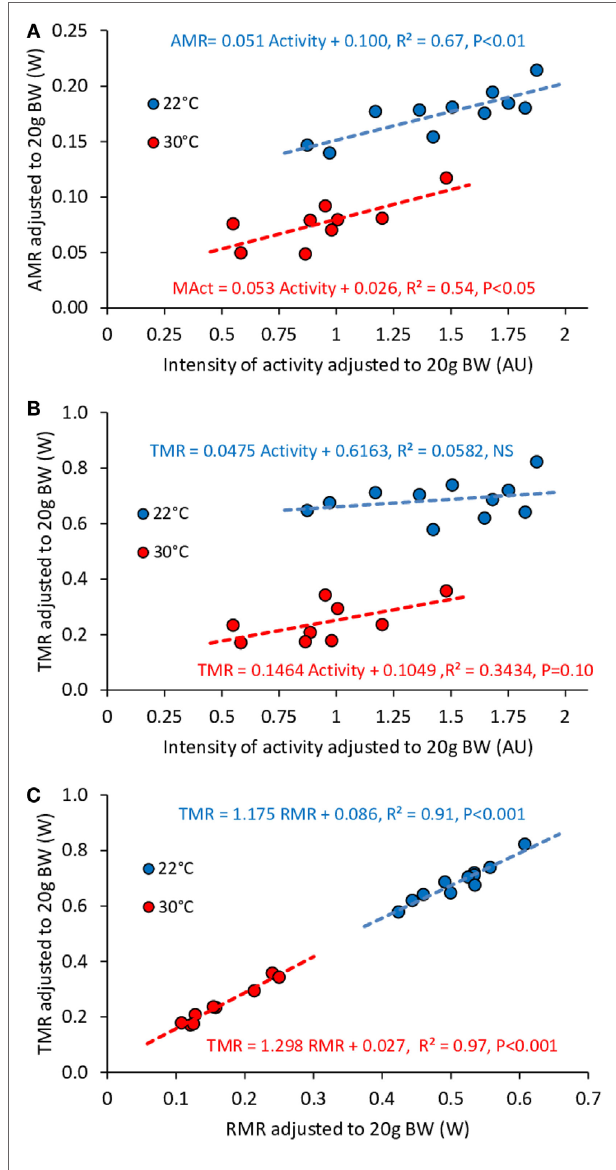
FigUre 7 | correlation between aMr and activity (a), TMr and activity (B), TMr and rMr (c) in ad libitum fed mice housed at 30°c ( n = 9) and 22°c ( n = 11) . Data are adjusted to 20 g BW. Despite the fact that intensity of activity affects significantly AMR, the consequences on TMR are not significant. The strongest predictor of TMR appears to be